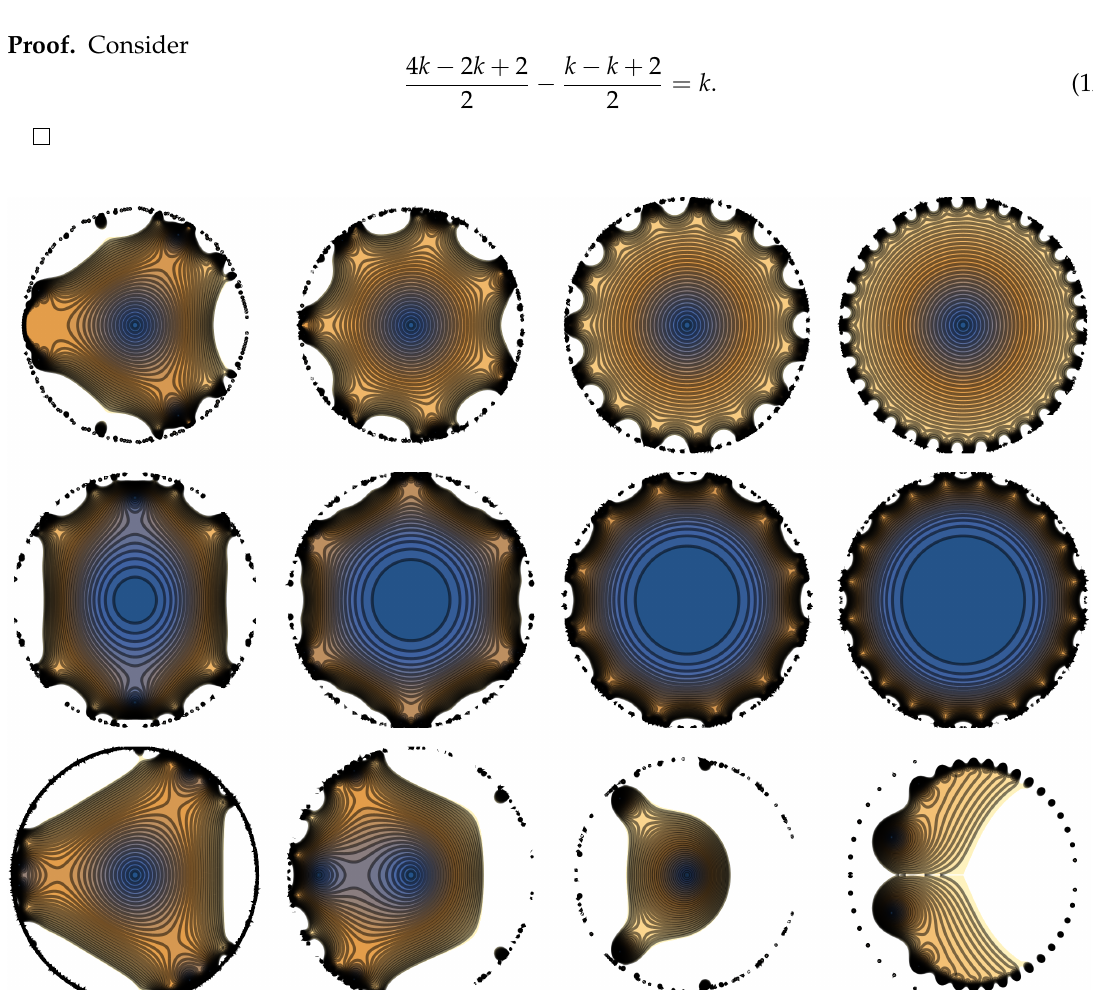
Figure 3. Contour plot of | L ( g ( n ) ; z ) | for a variety of g ( n ) and N = 16. The 30 contours (level sets) are plotted from 0 to 1. Blue shading represent low values and orange shading represents high values. The top row is g ( n ) = n m for m = 2,3,4,5. The second row is g ( n ) = m n for m = 2,3,4,5. The third row is g ( n ) = n n , g ( n ) = n !, g ( n ) = fib ( n ) , where fib ( n ) is the n th Fibonacci number and g ( n ) = n ln n . The strict rotational symmetry is broken but a quasi-rotational symmetry persists for all but the last three cases. In contrast to the plots of Figure 2, the contours are rough in all cases. This is typically the case for general lacunary